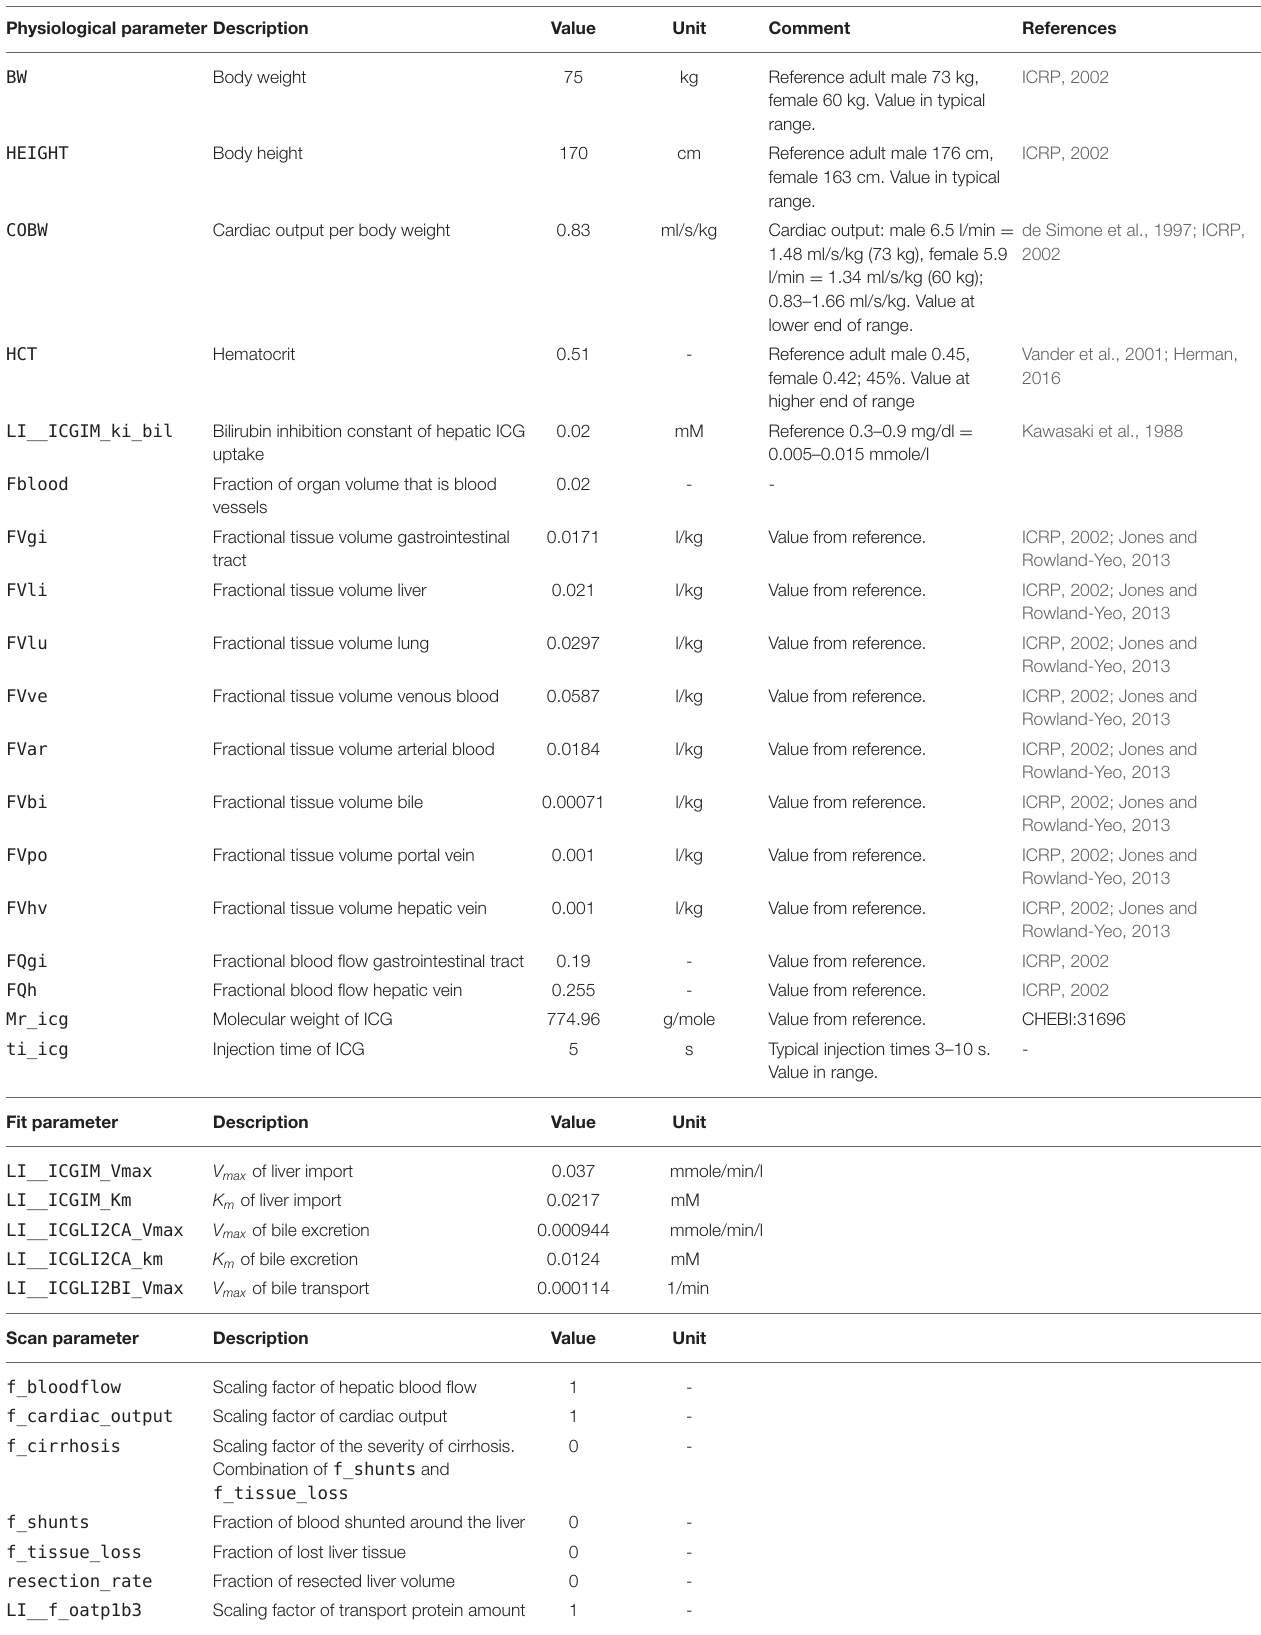
TABLE 2 | Overview of fixed model parameters. Physiological parameter